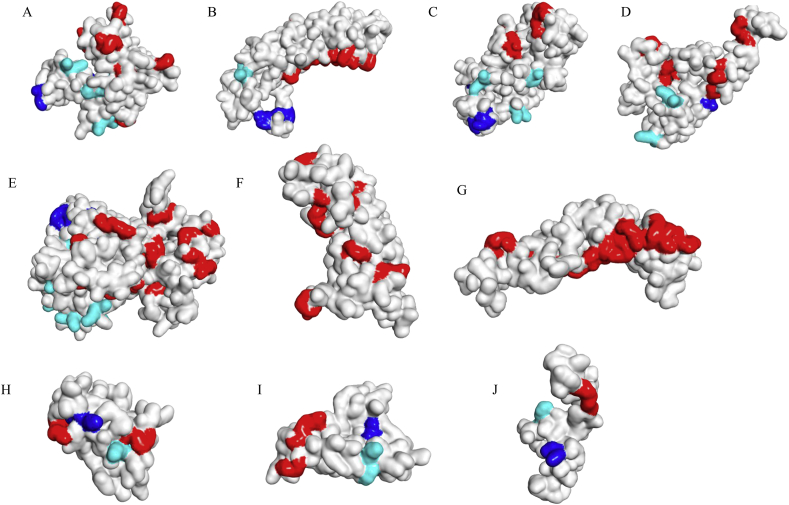
Conformational B-cell epitopes prediction for the final multi-epitope constructs by Ellipro. A. Construct 1, B. Construct 2, C. Construct 3, D. Construct 4, E. Construct 5, F. Construct 6, G. Construct 7, H. Construct 8, I. Construct 9 and J. Construct 10. The epitopes are represented as colored spheres in the final vaccine model where each color represents one epitope.